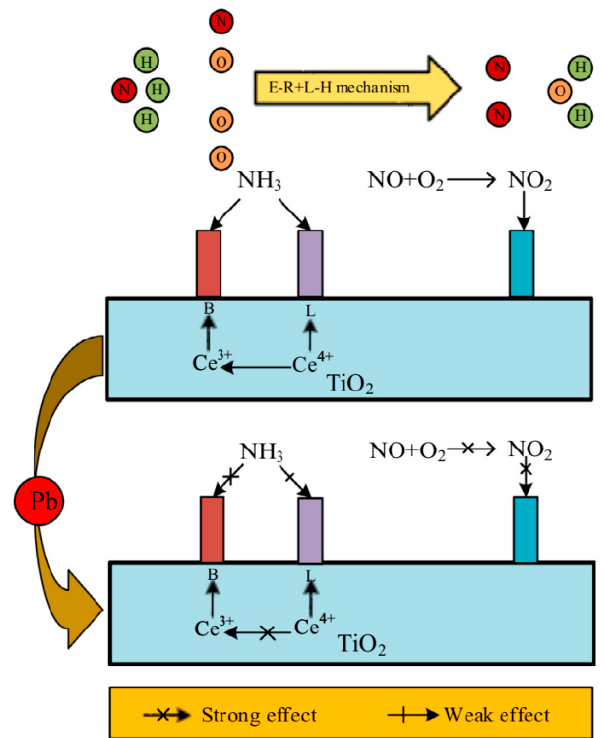
Figure 17. Schematic diagram of Pb poisoning on CT [69].